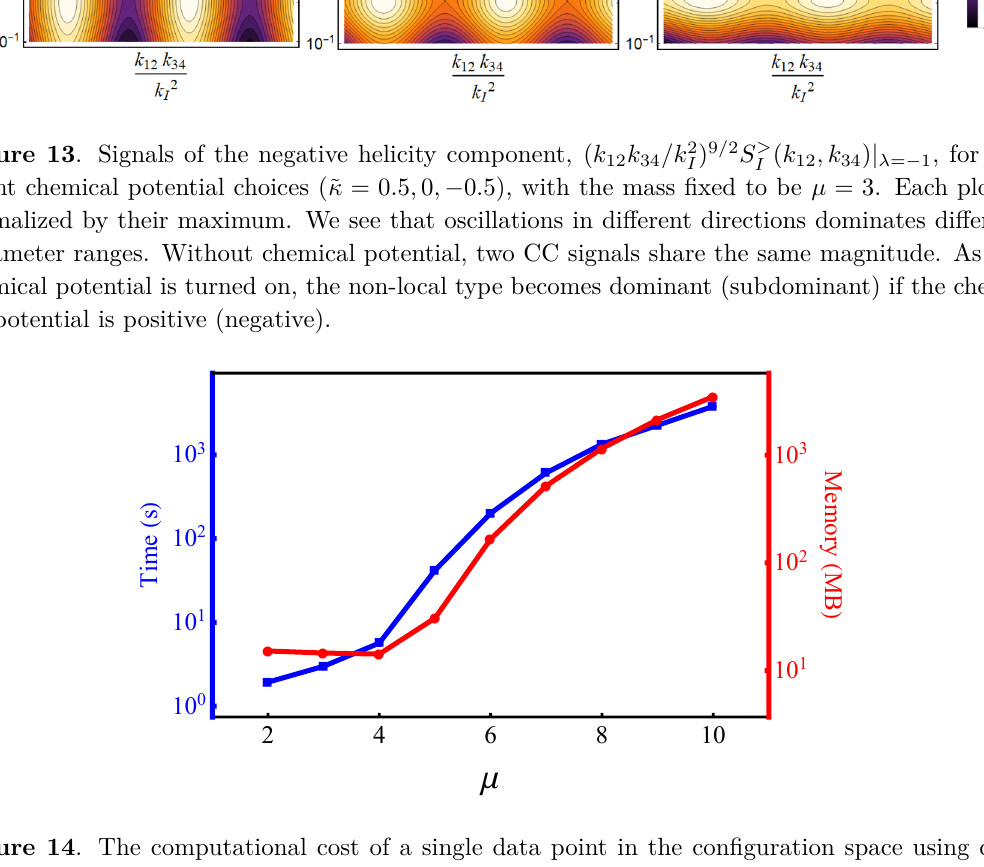
Figure 14 . The computational cost of a single data point in the configuration space using con- ventional numerics. The blue line and the red line show the time and memory consumption of computing figure 11 with k 12 = k 34 = 20 k I , where the relative numerical error is targeted at O (10 − 3 ) . The chemical potential ˜ κ is chosen as µ − 2 . As a comparison, the computational cost using the cut result is much lower, being around O (10 − 3 ) s and O (10 − 2 )